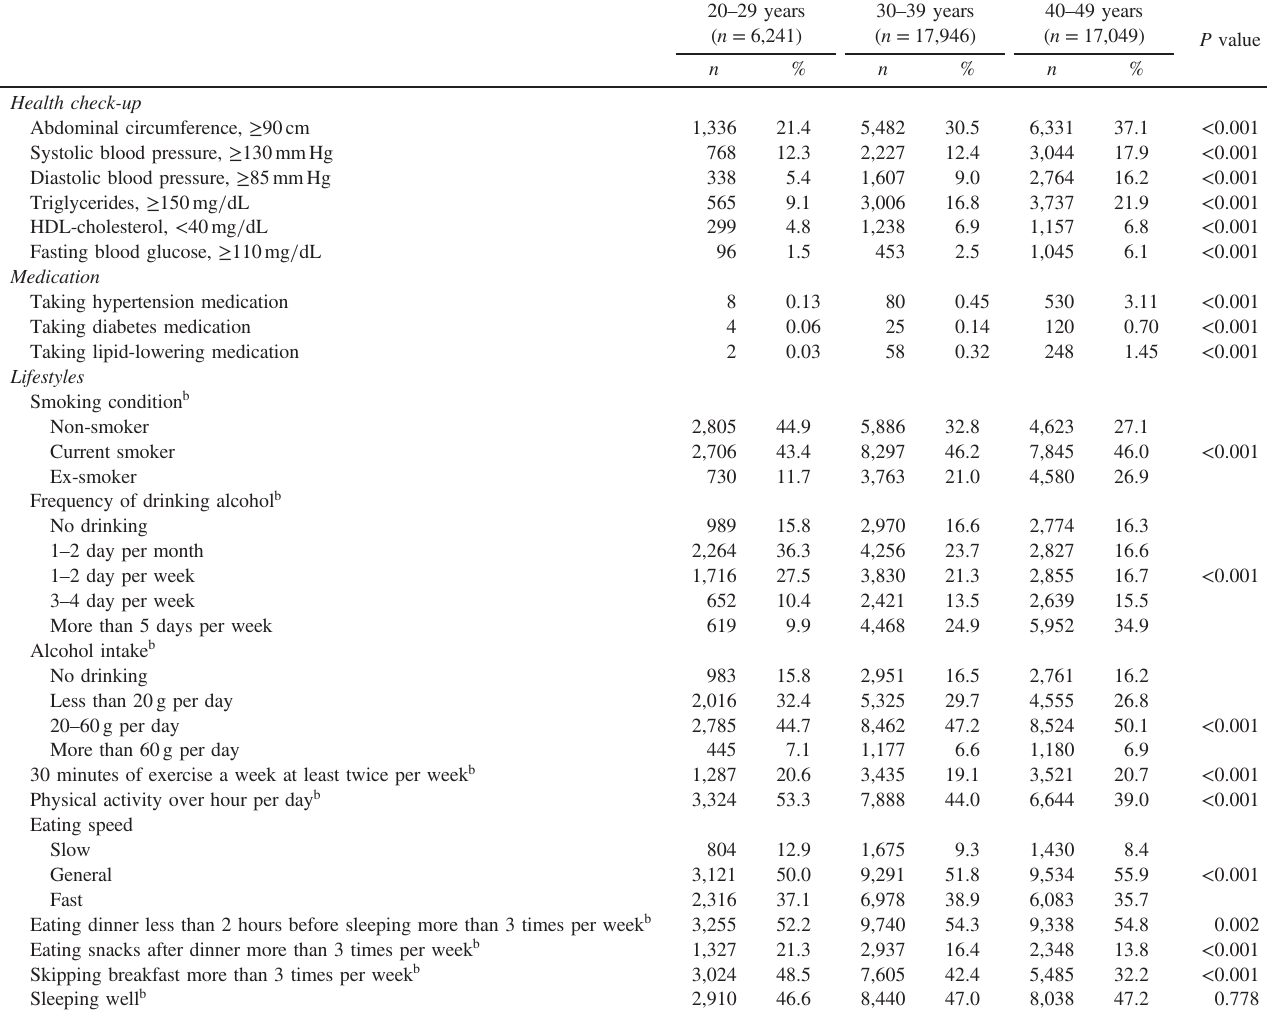
Table 2. Characteristics of men participants at baseline